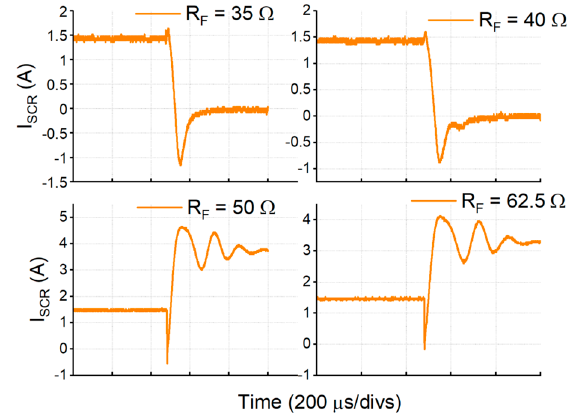
Figure 8. The ZCB’s cutoff behavior in the cases of the unity multiplication factor.